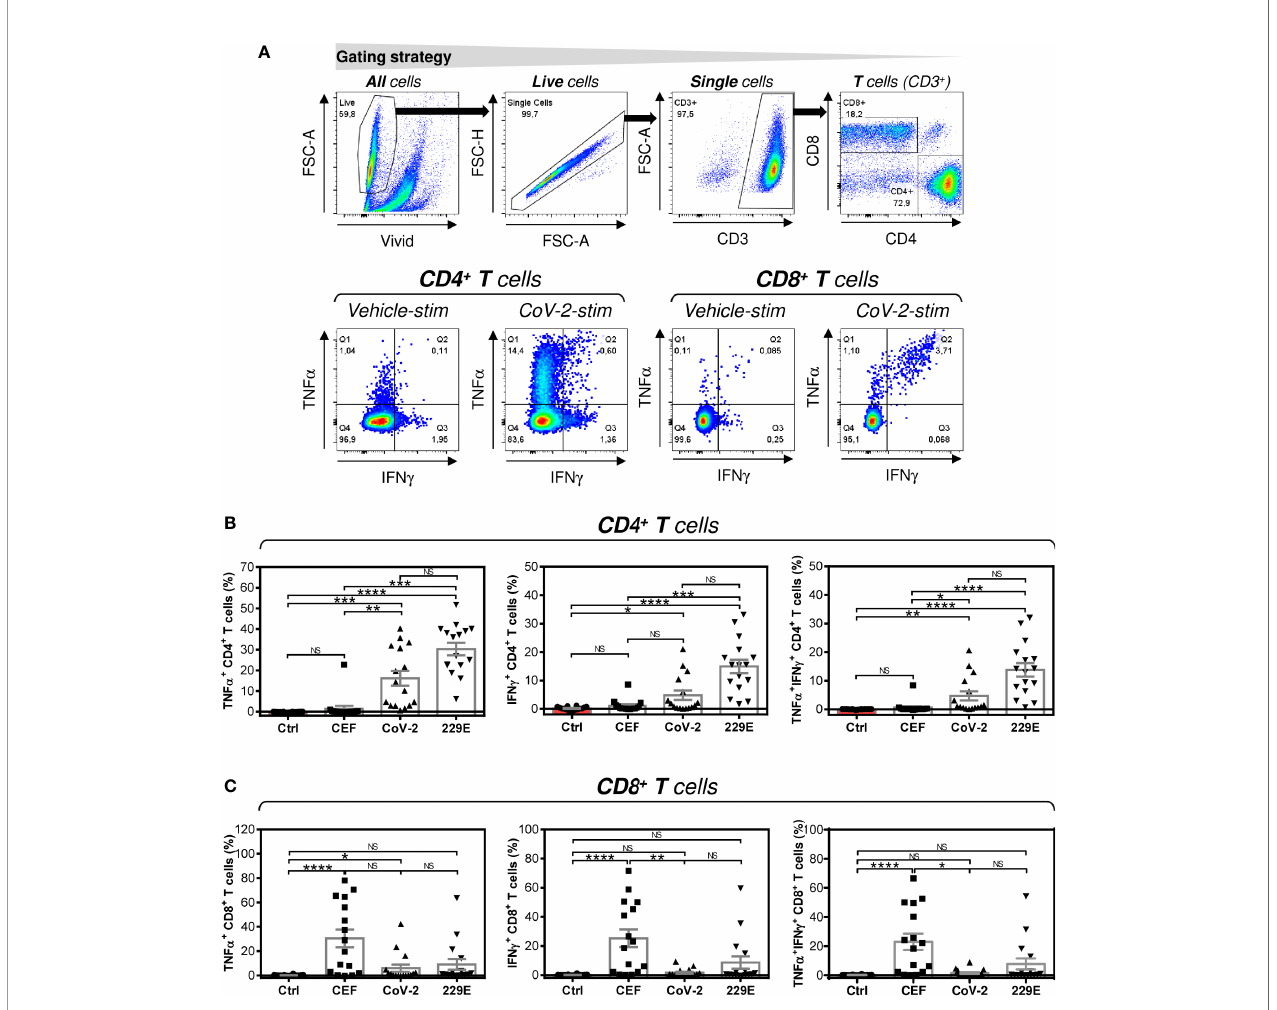
FIGURE 2 | Peptide pool-mediated cell culture enrichment with the peptide-speci fi c TNF a -, IFN g -, or TNF a /IFN g -producing CD4 + and CD8 + T cells (A) The gating strategy used to analyze fl ow cytometry data. The gating of CD4 + and CD8 + T cells ( top panels ). The gated CD4 + and CD8 + T cells stimulated without peptides (Vehicle-stim) or with SARS-CoV-2 (CoV-2-stim) peptide pool were gated to determine the proportions of TNF a - (Q1+Q2), IFN g - (Q2+Q3), or TNF a /IFN g - (Q2) producing cells ( bottom panels ). (B) Cell cultures enriched with CEF (CEF), SARS-CoV-2 (CoV-2), or HCoV-229E (229E) peptide pools were stimulated with the corresponding peptide pools and proportions of TNF a -, IFN g -, or TNF a /IFN g -producing CD4 + T cells was determined. As a control (Ctrl), the cell culture enriched with no peptide (Vehicle) and stimulated with the SARS-CoV-2 peptide pool was used. (C) Cells in (B) were analyzed for the proportions of TNF a -, IFN g -, or TNF a / IFN g -producing CD8 + T cells. In (B, C) , bars represent mean of values and SEM determined in each group and signi fi cances of differences among the groups are indicated (* P <0.05, ** P <0.01, *** P <0.001, **** P <0.0001, n = 16 donors (6 healthy male donors and 10 HR metastatic PCa patients), 1-way ANOVA with the Dunn ’ s posttest). P >0.05 were considered nonsigni fi cant